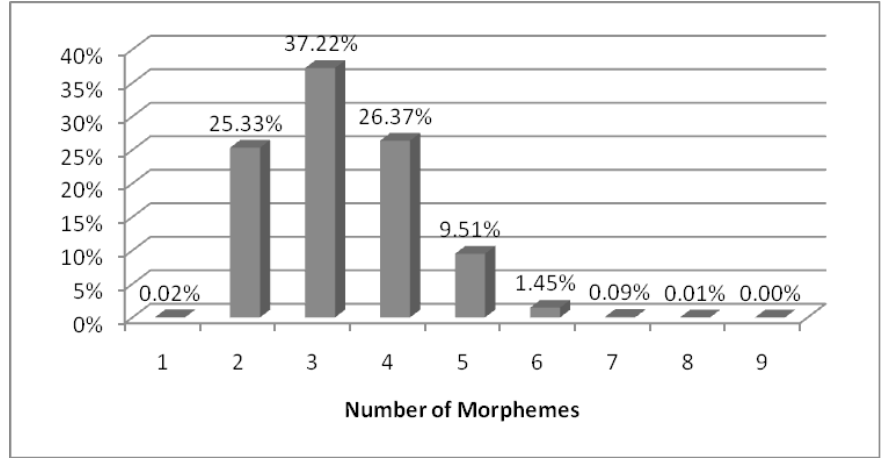
Figure 6. Percentage of Verbs with a Different Number of Morphemes Quadri-morphemic nouns make up 26% of all verbs (16 models). The four most frequent quadri-morphemic models are PRS F (7.2%, e.g. ne- gal -im-a ‘not allowed’ (participle, passive voice, present tense, neutral)), i RS S F (4.7%, mostly participles , naud -oj-am-i ‘used’ (participle, passive voice, present tense, masculine, d i plular, Nominative)), PRS S (3.8%, mostly infinitives, e.g. nu- stat -y-ti ‘to define’), PdRF (3.2%, e.g. d i